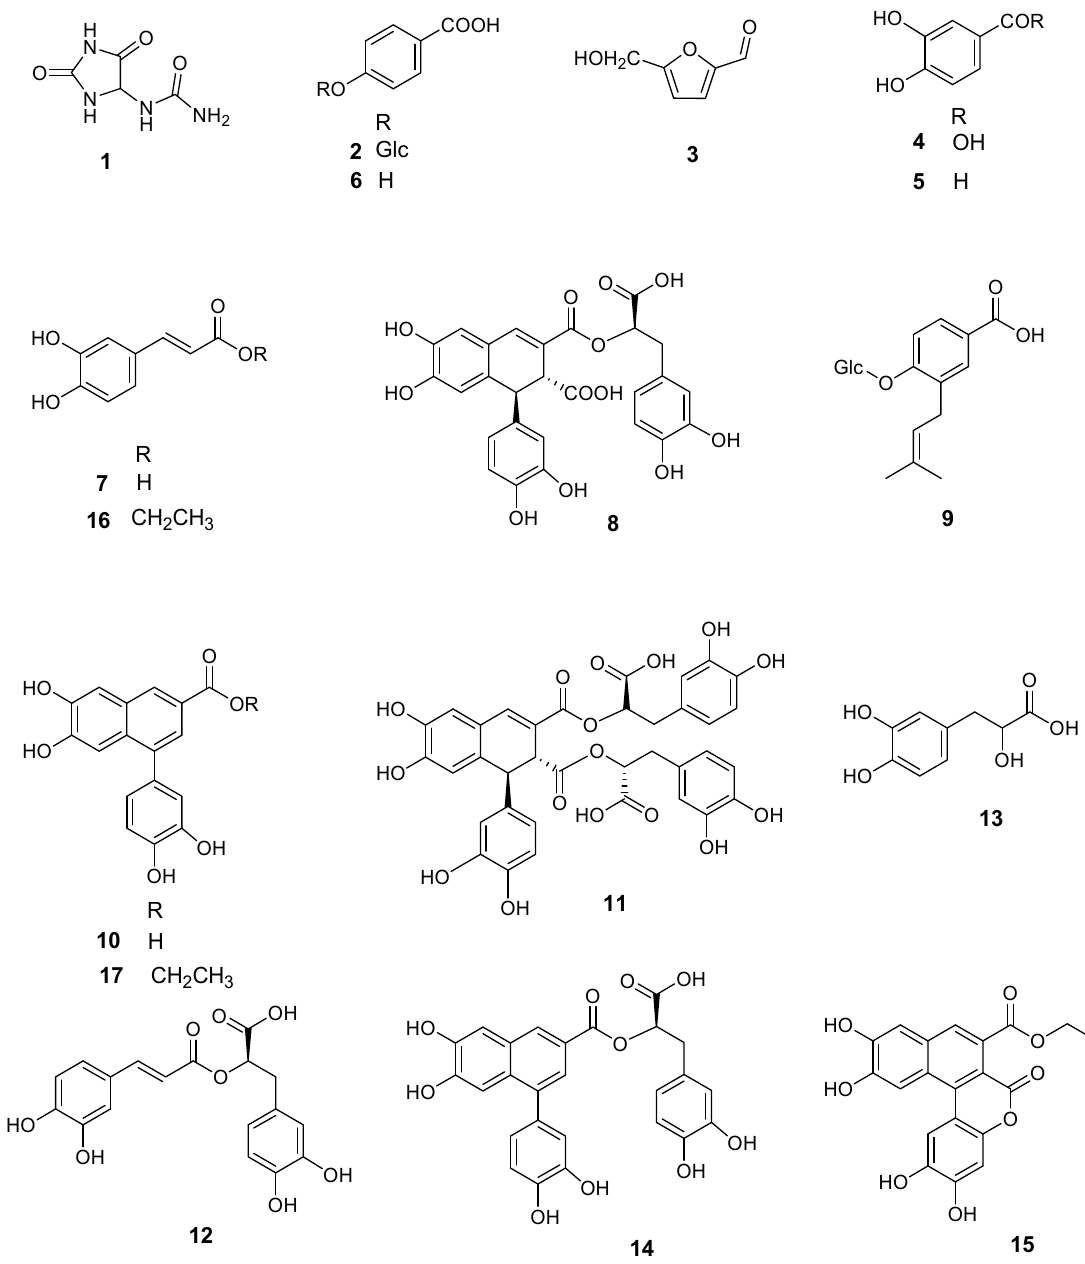
Figure 2. Compounds isolated from the roots of Symphytum officinale .